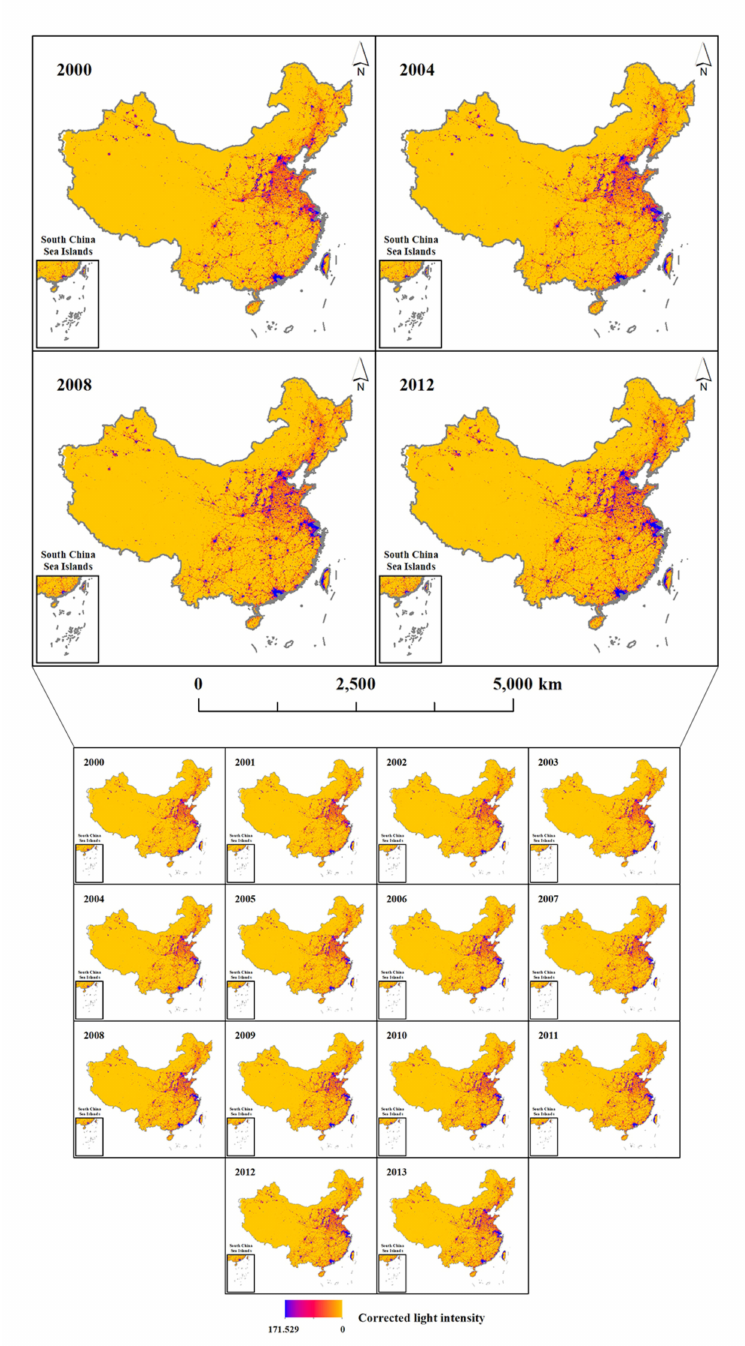
Figure 8. Spatial distribution map of corrected DMSP nighttime light data in China from 2000 to